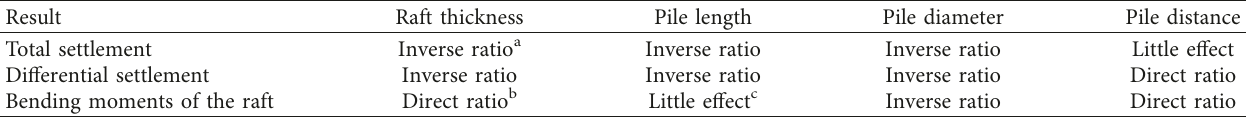
Table 1: The relationships between the parameters of the